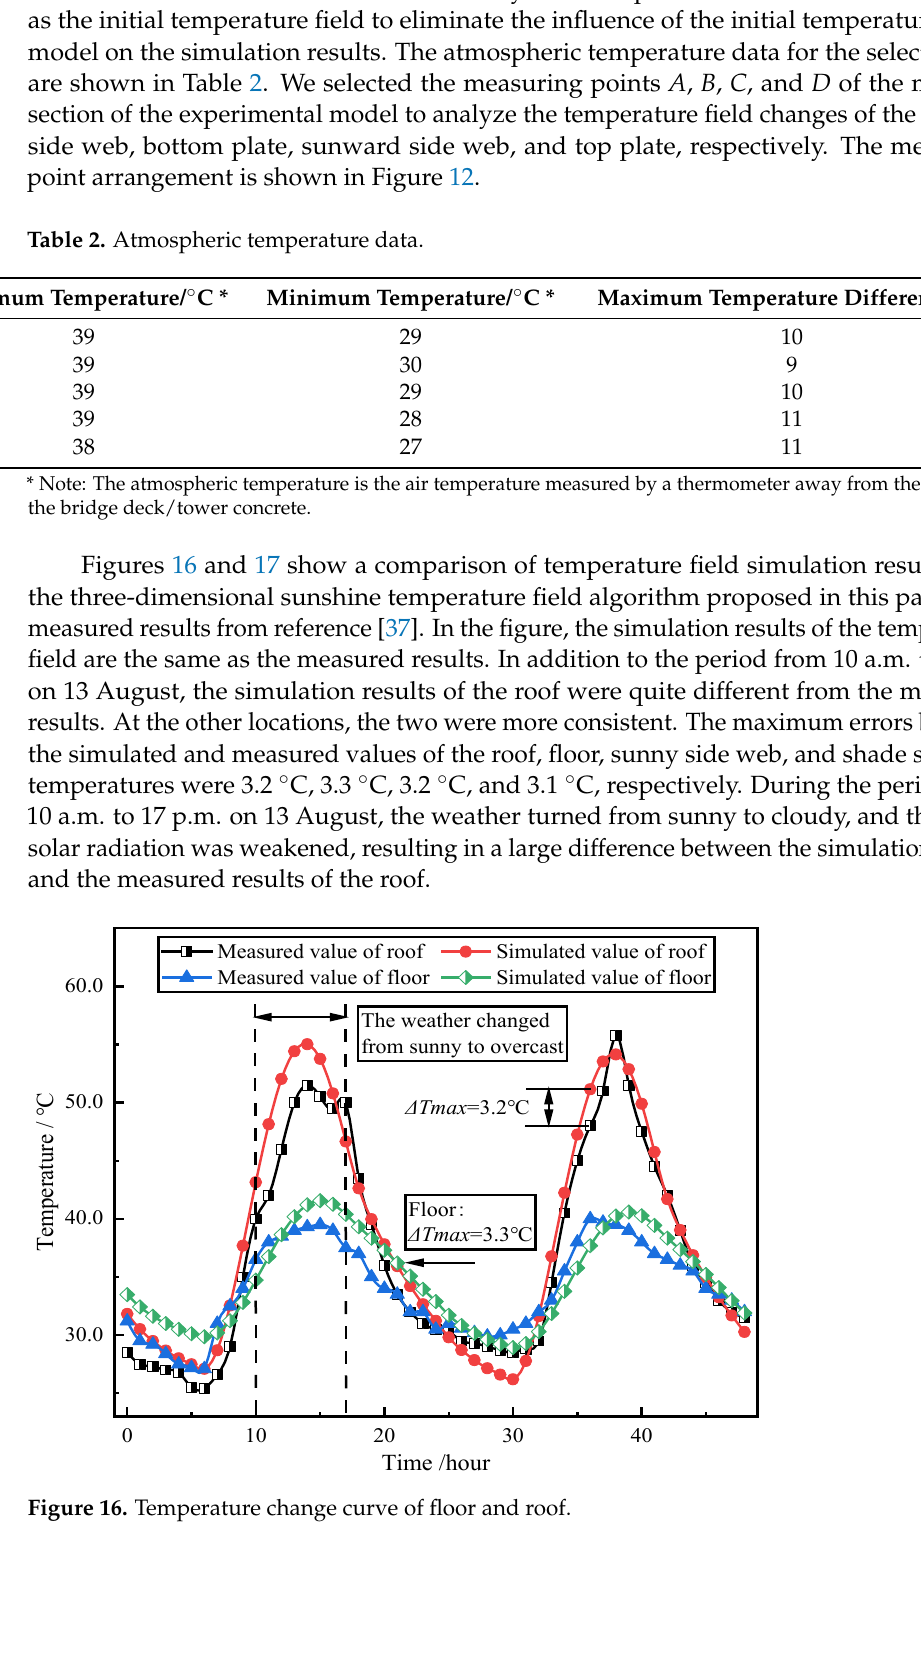
Shade side web: ΔTmax =3.1℃ Figure 17. Temperature change curve of the web on the sunward side and shaded side. To sum up, the calculation results of the sunshine shadow and temperature field ob- tained by the calculation algorithm of the three - dimensional temperature fie ld of the